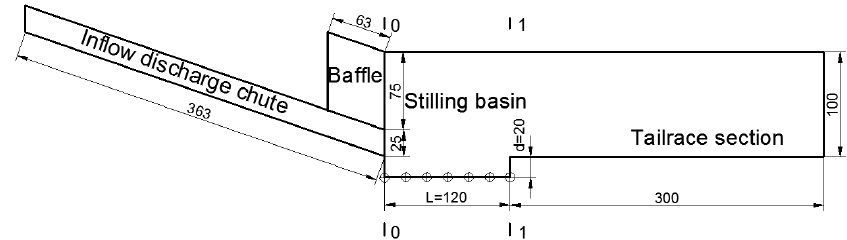
Figure 1. Schematic design of the model test (in cm).